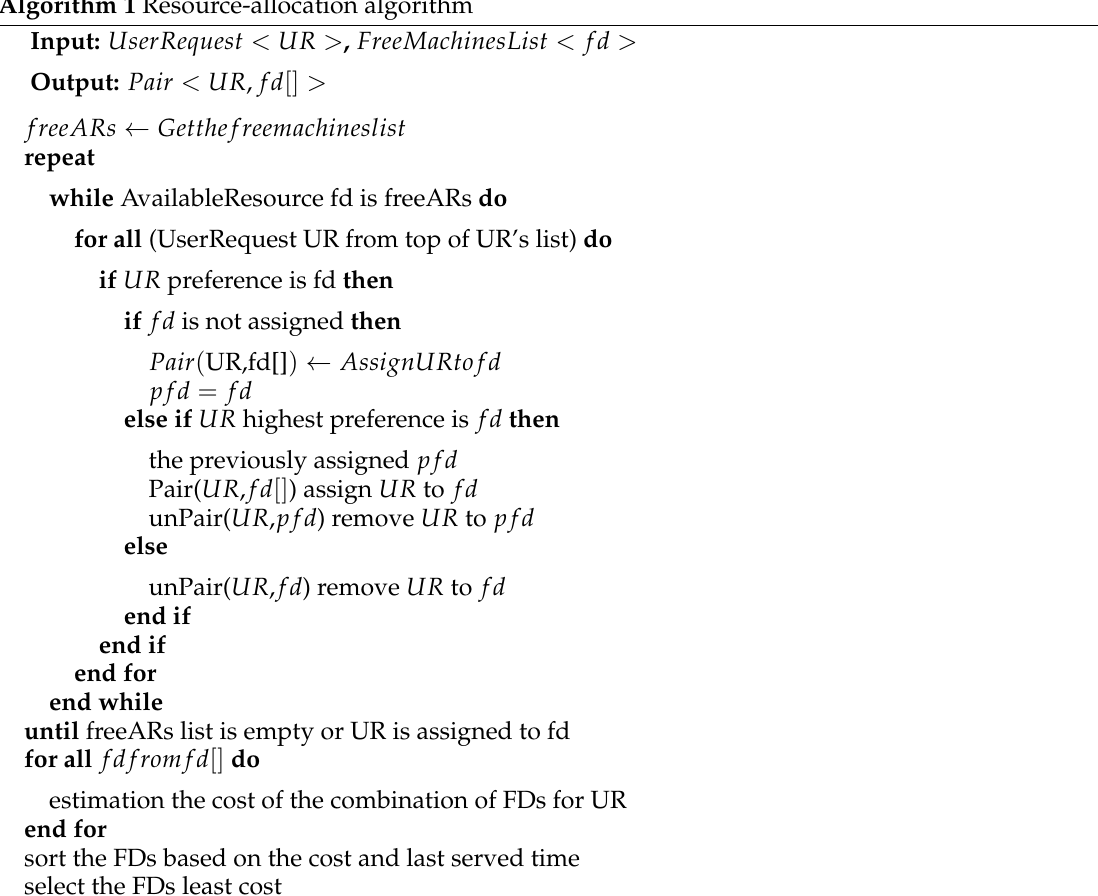
Algorithm 1 Resource-allocation algorithm